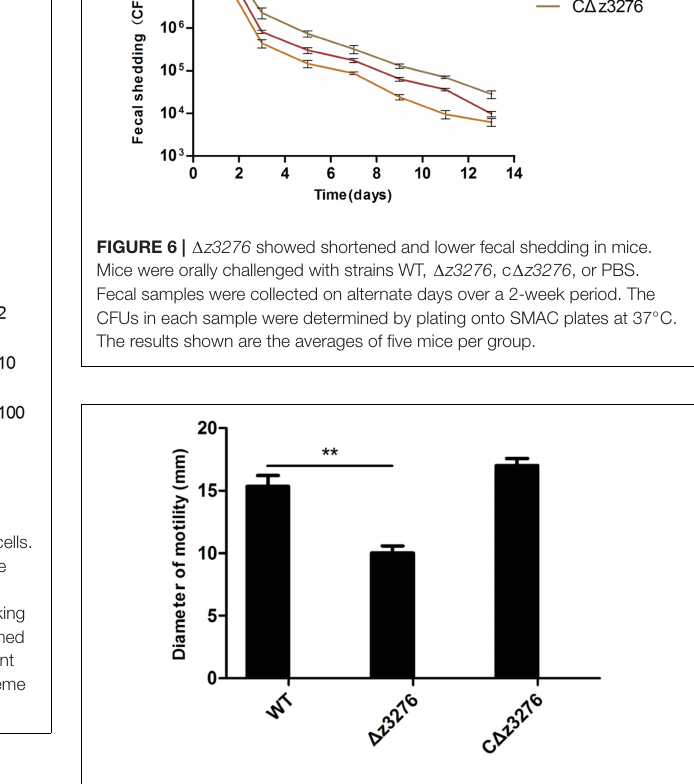
FIGURE 7 | Swimming motility diameter of WT, (cid:49) z3276, and c (cid:49) z3276 . Data represent the means ± SEM of three separate experiments. ∗∗ Indicates extreme significance at P <